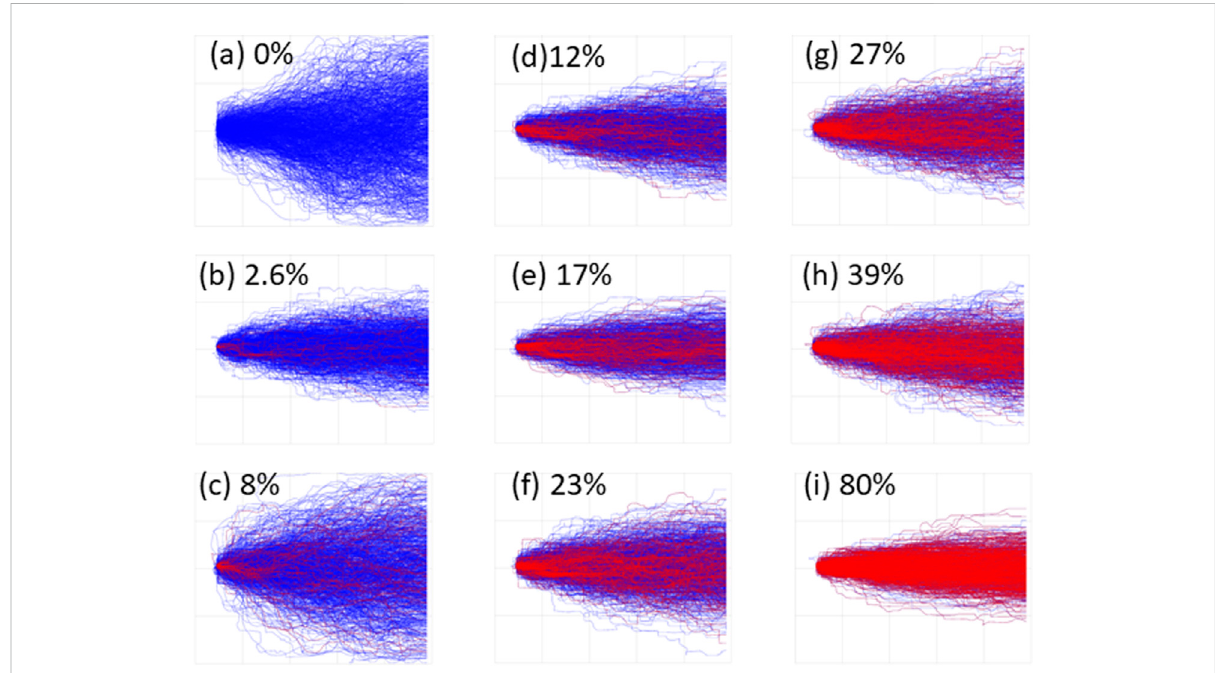
FIGURE 7 Particle tracks for selected TP models (a – i) are shown in blue. Particle tracks for plausible realizations for each model are shown in red. The acceptance probability for each of the fi gures are shown alongside the relevant model